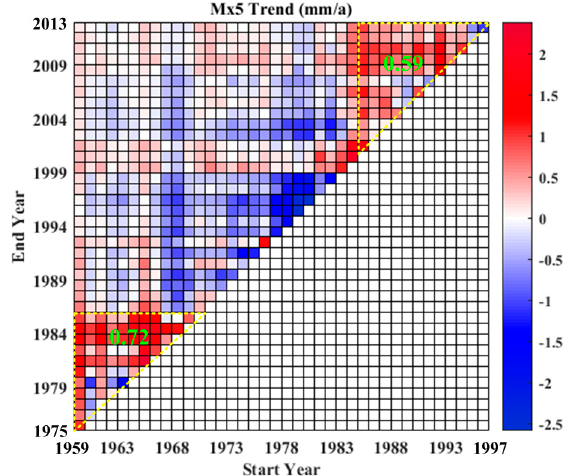
Figure 6. Median Sen’s slopes in P95 , E–NE and Mx5 among 29 stations during different time spans for periods with different starting years (1959–1997) and ending years (1975–2013). Median Sen’s slopes within the downward yellow triangle were from 1959 to 1985, while median Sen’s slopes within the upward yellow triangle were from 1986 to 2013. (/a = per annual).